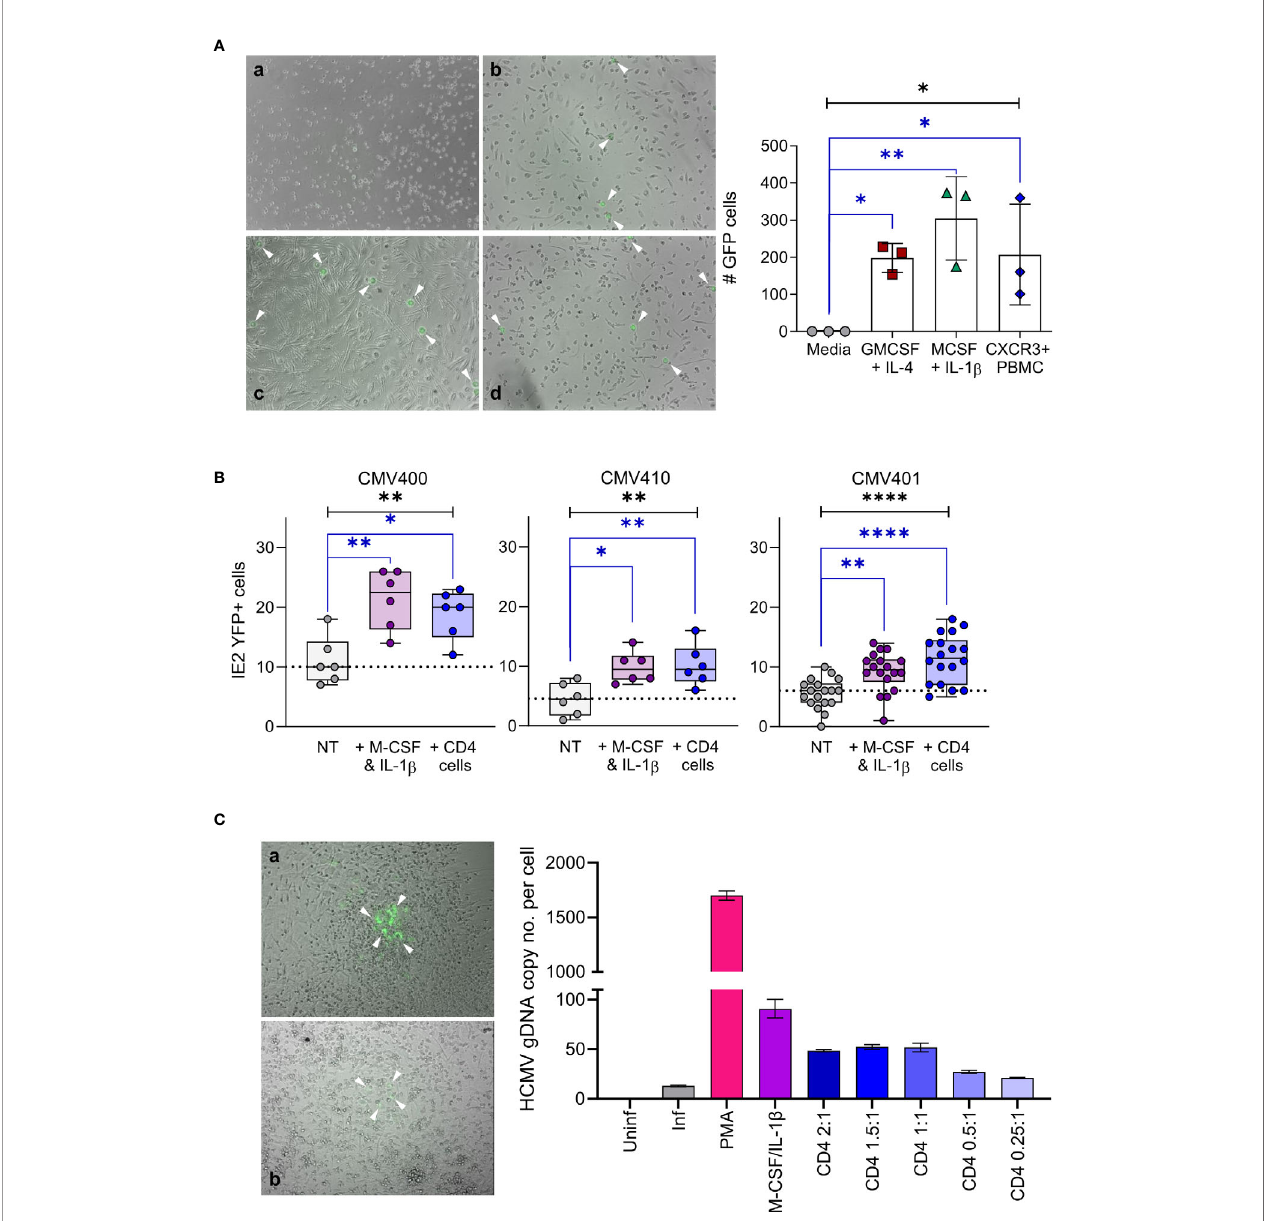
FIGURE 6 | Activated CD4+ T cells can reactivate HCMV infection of latent infected monocytes. (A) CD14+ monocytes from a CMV sero-negative donor were infected with TB40/E UL32-GFP virus and co-cultured with activated PBMC or treated with cytokine cocktails (GM-CSF & IL-4 or M-CSF & IL-1 b ), virus reactivating GFP positive cells (white arrows) were visualized by microscope (right-hand panel – a Media, b M-CSF, c CXCR3+ PBMC & d GM-CSF) and enumerated (left-hand graph). All treatment conditions results in signi fi cant levels of GFP expressing cells representing reactivated virus (1-way ANOVA (black line: p=0.0112*) with corrected Dunnets post-test (blue lines: GM-CSF p=0.044*, M-CSF p=0.0048**, PBMC p=0.0363*). Shown is one representative donor of 4 different donors analyzed. (B) CD14+ monocytes latently infected with TB40/E IE2-YFP virus were co-cultured with activated CD4+ T cells or treated with M-CSF & IL-1 b in 3 CMV sero-negative donors, reactivating YFP positive cells were enumerated. Both activated CD4+ T cells and M-CSF & IL-1 b signi fi cantly increased reactivation of HCMV from latently infected autologous CD14+ monocytes (Kruskal Wallis 1-way ANOVA (Black line: CMV400 p=0.0049**; CMV410 p=0.0078**; CMV401 p<0.0001****) and Dunn ’ s post-test (Blue line CMV400 MCSF p=0.003**, CD4 p=0.03*; CMV410 M-CSF p=0.0133*, CD4 p=0.0098**; CMV401 MCSF p=0.0086**, CD4 p<0.0001****)). (C) CD14+ monocytes latently infected with TB40/E IE2-YFP virus were co-cultured with activated CD4+ T cells, treated with M-CSF & IL-1 b or treated with PMA, then the cultures were overlaid with fi broblasts to measure the production of infectious virions. The resulting plaques were visualized by microscope (left-hand panel – a M-CSF & b Act CD4+ Treated) and IE2-YFP infected fi broblast plaques are indicated (white arrows). The infection of fi broblasts was quanti fi ed by measurement of genomic HCMV DNA present in each condition (right-hand graph), HCMV genome copy number was determined by qPCR of UL44 promoter relative to host GAPDH promoter. This demonstrates that detection of IE2-YFP positive monocytes can be used as a surrogate for the production of infectious virions in this